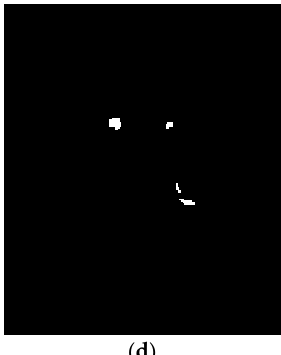
Figure 8. Lesion detection of Slice 97 with 5% noise and 0% INU by CBEP-ICEM1 and CBEP-ICEM2. ( a ) Original 97th slice of MS MR brain images with 5% noise and 0% INU; ( b ) CBEP-ICEM1; ( c ) CBEP-ICEM2; ( d ) Lesion detection LST.